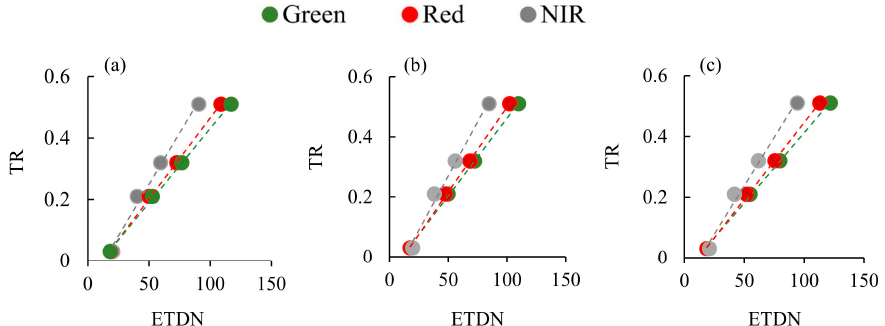
Figure 5. Relationships between the DN values of the four different reference tarps with reflectances of 3.1%, 21%, 32%, and 51% and light intensity (LI) at photosynthetically active radiation (400–700 nm). TDN: tarp digital number.